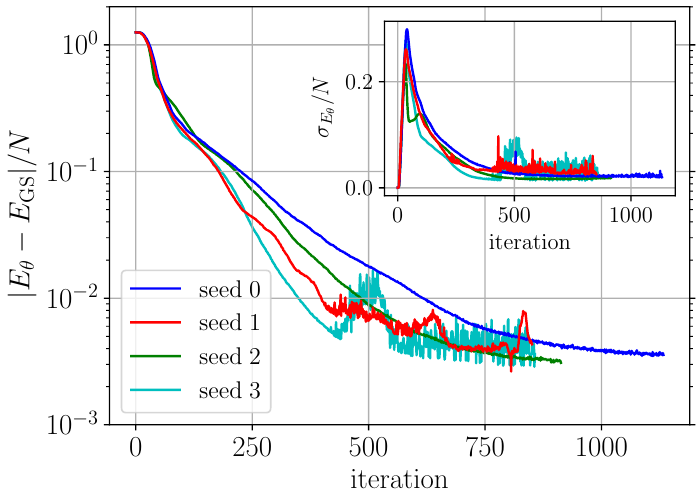
Figure 12: Variational energy density against the iteration number for different seeds of the pseudo-random number generator. Inset: energy variance per spin. The sys- tem size is N = 6 × 6. The network architecture is listed in App. H, and J Optimization was done using RK in combination with SR, see App. A. The MC sample = 10 5 size is N MC